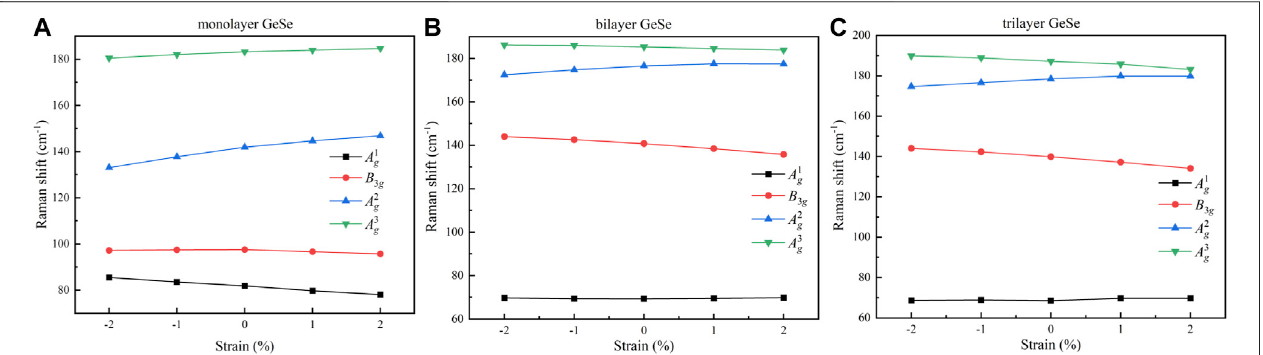
FIGURE 3 | The in fl uence of the Raman frequency on strain from − 2 to 2% for (A) monolayer, (B) bilayer and (C) trilayer GeSe.